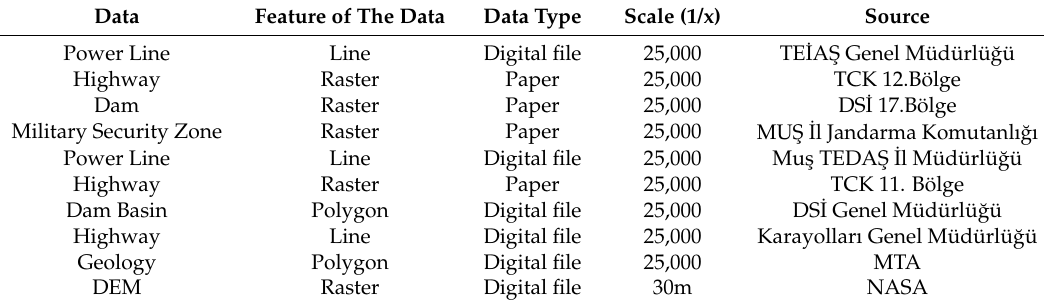
Table 1. Project data and